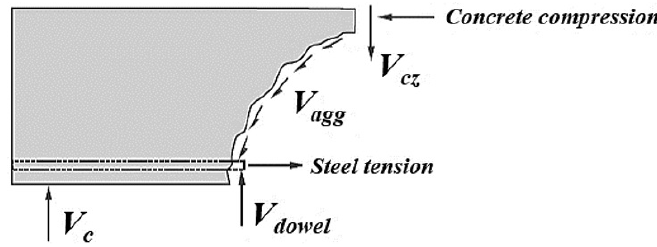
Figure 1. Shear transfer mechanism in RC